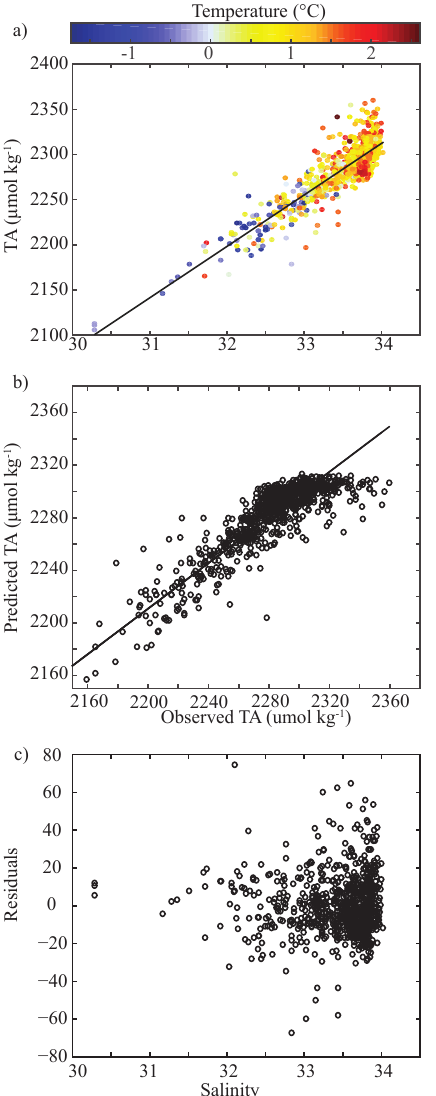
Figure A2. Evaluation of the total alkalinity (TA), µmolkg − 1 algorithm. (a) Measured TA as a function of salinity and temperature (color), (b) measured TA vs. predicted TA, and (c) residuals vs.